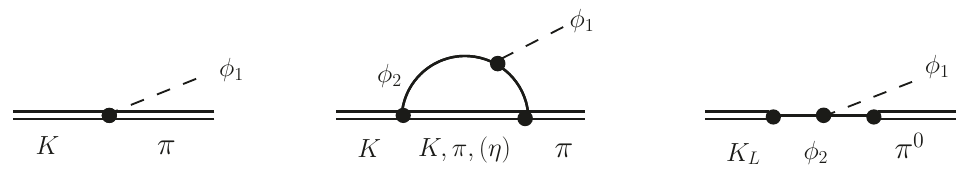
Figure 3 . Diagrams for the K (cid:25)(cid:30) 1 decay in Model 1 with the GN-violating contribution to the ! very right. These diagrams enter the matrix elements in eqs. (3.13), (3.14). Note that the (cid:17) in the loop contributes to the K L decay only. Diagrams which we neglect, such as the diagrams of or ( g 3 ), are not qq 0 O